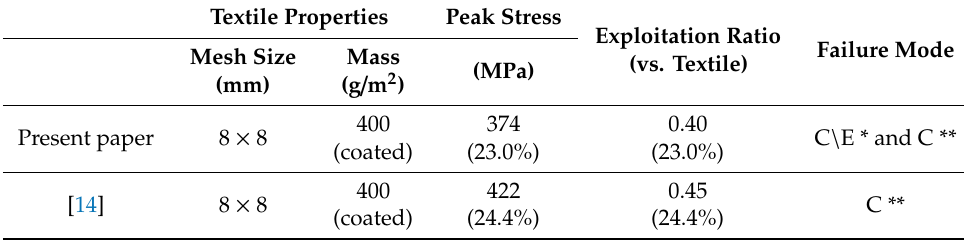
Table 7. Direct shear tests results: FRAAM composite and commercial system [14].